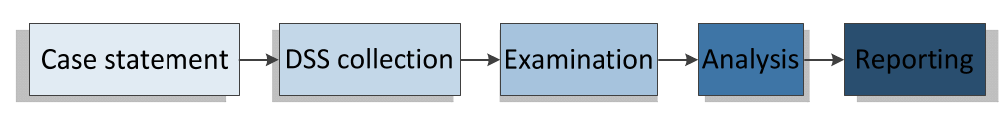
Figure 1. Digital Investigation